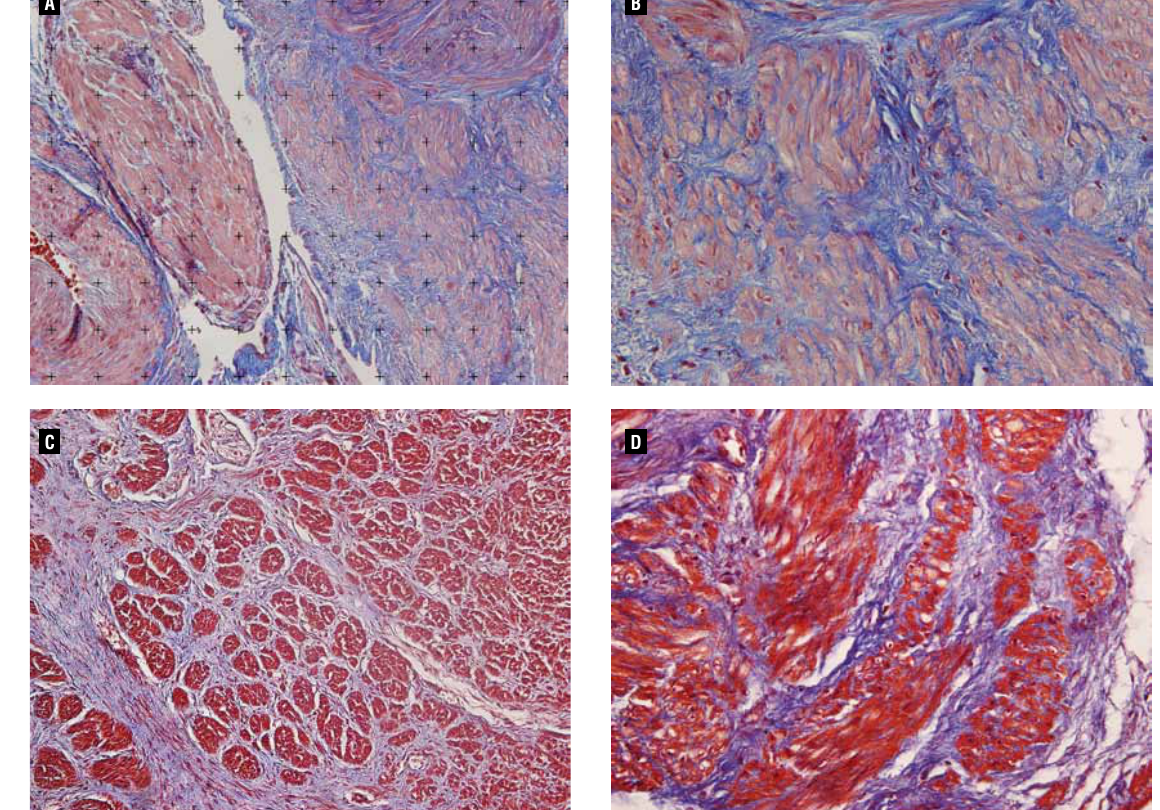
Figure 1 - Smooth muscle cells (SMC) distribution in urethral samples. A) Photomicrography of a control urethra showing the morphometric analysis. Quantification of smooth muscular cells using the software Image J Test grid. Masson’s trichrome X200. B) Smooth muscle cells (SMC) distribution in control group. Smooth muscle cells (SMC) distribution in proximal edge of stenotic group and d) Smooth muscle cells (SMC) distribution in distal edge of stenotic group. Note marked decrease of SMC(red) in the proximal edges and less marked decrease in the distal edge, when compared to controls (differences statisti- cally significant). Masson’s trichrome, X200.